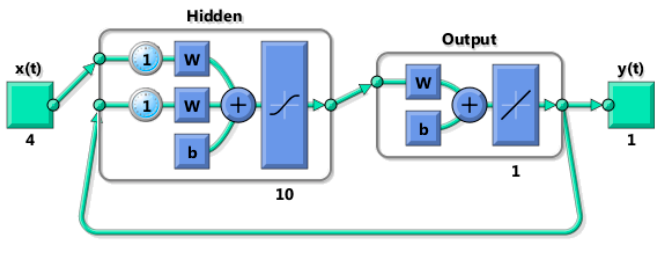
Figure 3. NARX network structure.